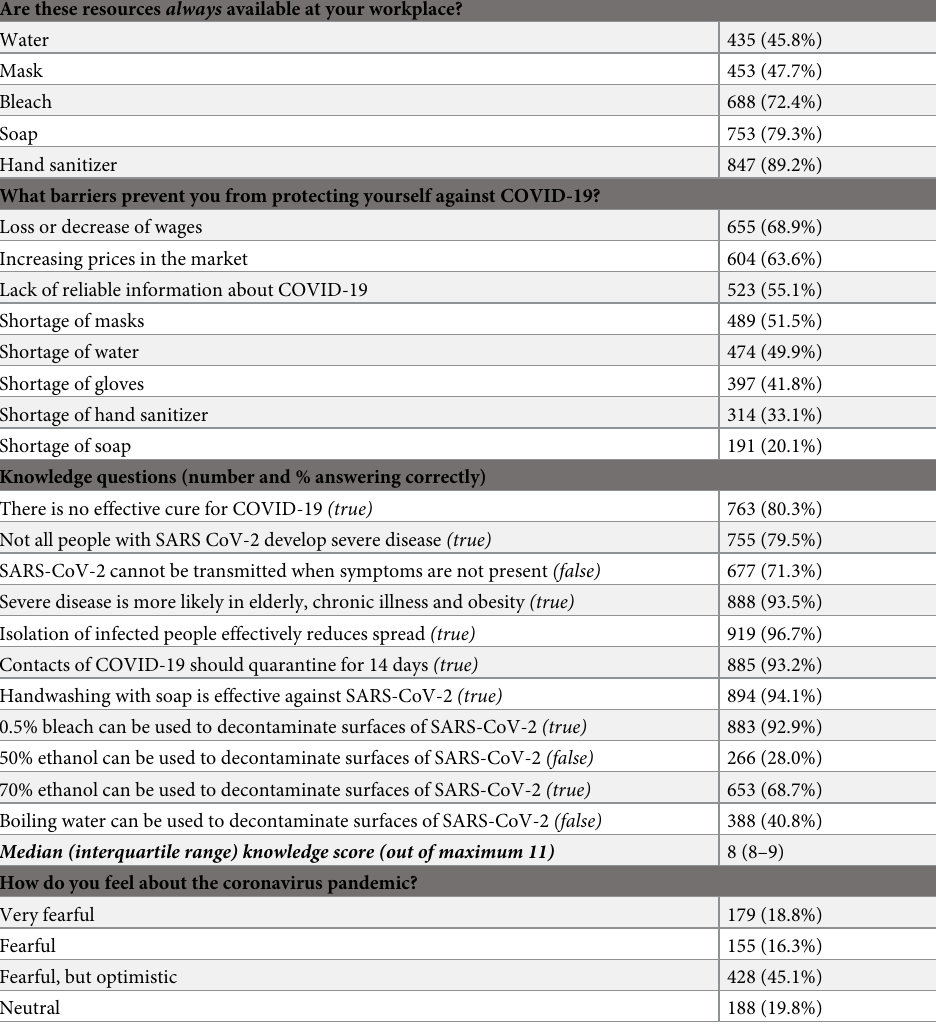
Table 2. Healthcare workers’ responses to questions about COVID-19 knowledge, attitudes, resources and chal- lenges (n = 950). Are these resources always available at your